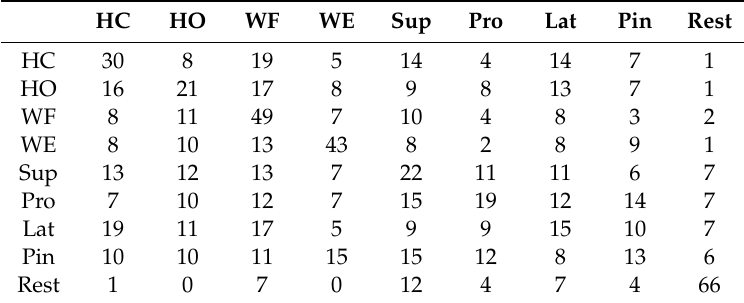
Table 8. Confusion matrix based on between-session calibration (the mean across the two days have been calculated) using a CNN. All values are in percent and presented as the mean across participants. HC (Hand Close), HO (Hand Open), WE (Wrist Extension), WF (Wrist Flexion), Sup